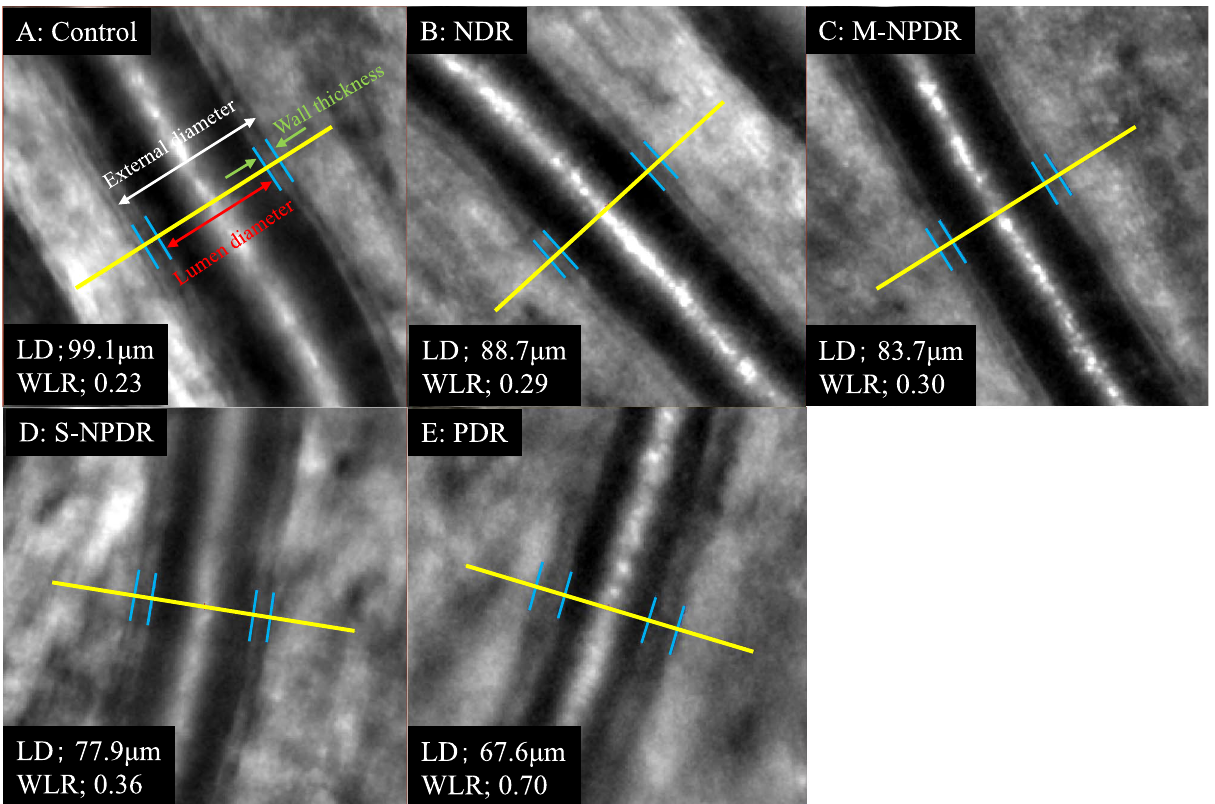
Figure 2. Representative images obtained with an Adaptive Optics device (images in each stages of diabetic retinopathy (DR). The images show the external diameter, the lumen diameter (LD), wall thickness, and wall to lumen ratio (WLR). Eyes in the control group ( A ); no diabetic retinopathy (NDR) group ( B ); mild or moderate non-proliferative diabetic retinopathy (M-NPDR) group ( C ); severe NPDR (S-NPDR) group ( D ); and PDR group ( E ) are shown. Eyes in the DR groups have higher WLR, especially in the PDR